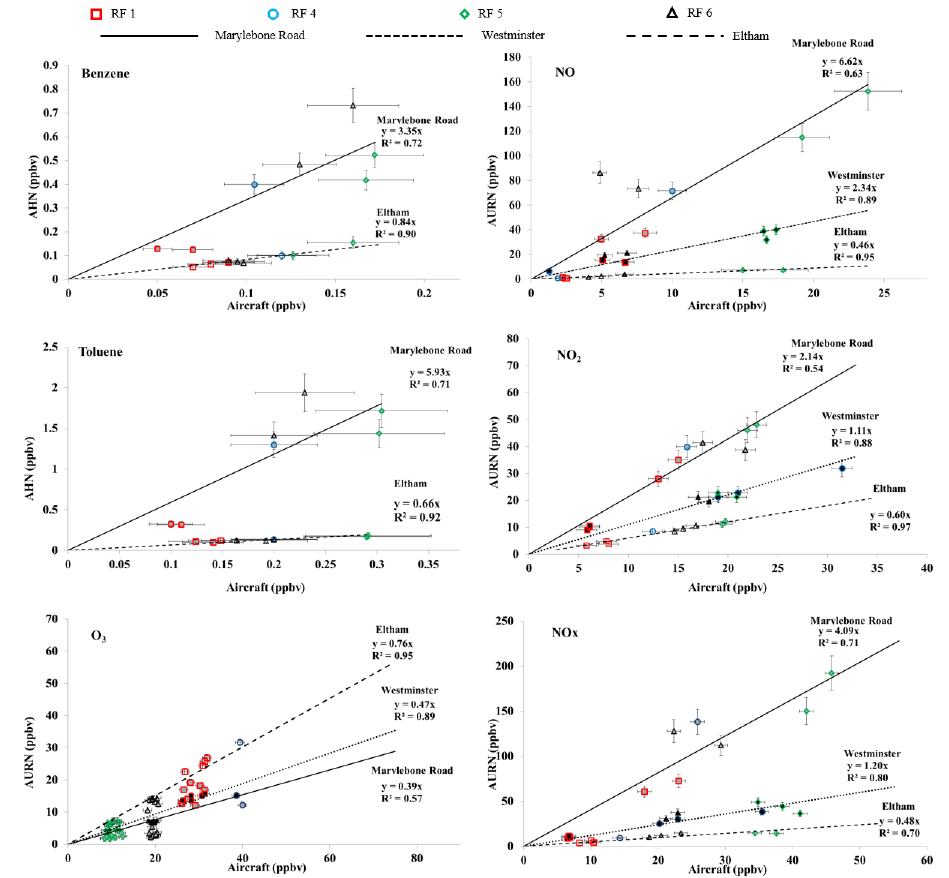
Figure 8. Linear regression analysis between airborne (at 360 ± 10ma.g.l.) and hourly ground measurements at Greenwich-Eltham (empty), Westminster-Horseferry road (black) and Marylebone Road (grey) from the LAQN monitoring network during RF1, 4, 5 and